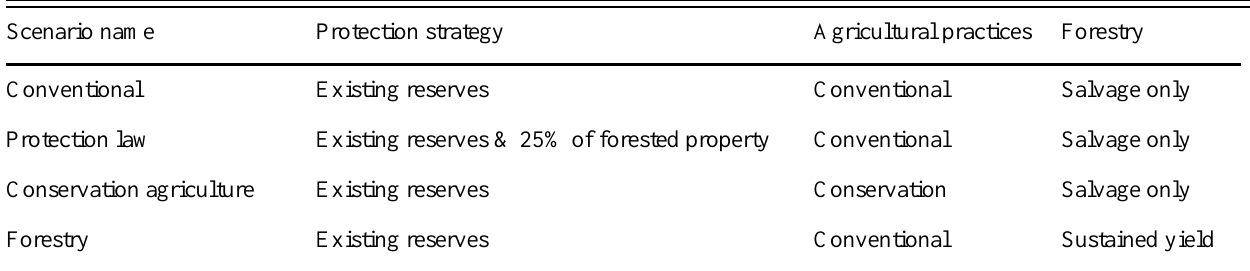
Table 1 . Land use scenarios simulated in the study. Scenario